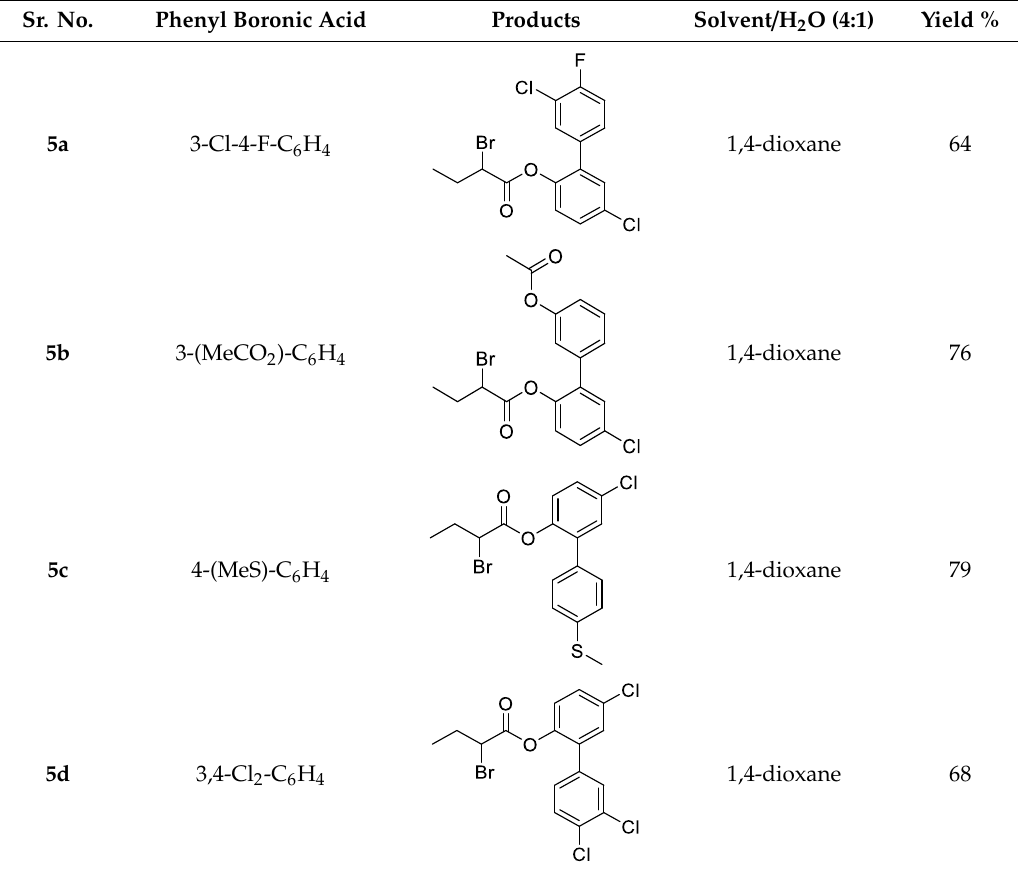
Table 1. Suzuki–Miyaura reaction of 2-bromo-4-chlorophenyl-2-bromobutyrate with different phenyl boronic acids.